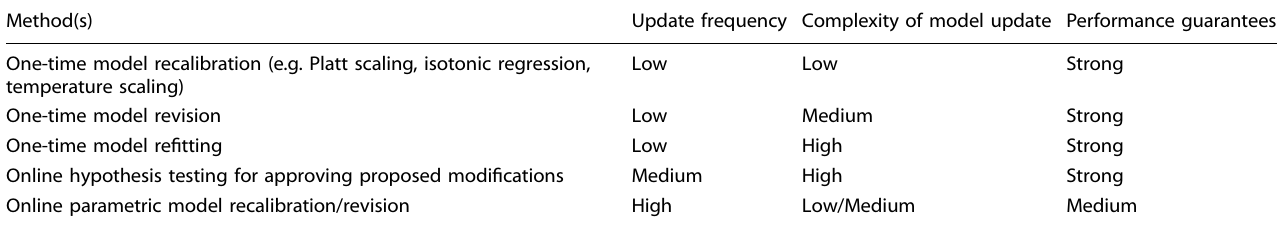
Table 2. Model updating procedures described in this paper. The performance guarantees from these methods require the stream of data to be IID with respect to the target population. Note that in general, online learning methods may provide only weak performance guarantees or none at all. Method(s) Update frequency Complexity of model update Performance guarantees